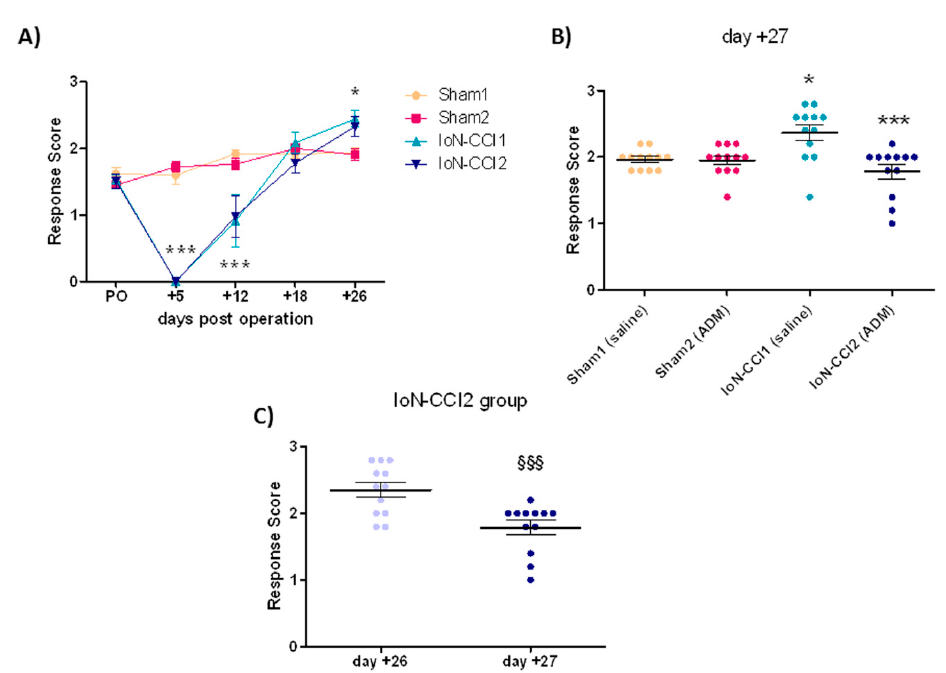
Figure 1. Mechanical stimulation testing (MST): ( A ) Mean response score to Von Frey hair stimulation of the ligated/sham infraorbital nerve (IoN) territory, on pre-operative day (PO) and on +5, +12, +18, and +26 days post operation. Data is expressed as mean ± SEM. Two-way ANOVA followed by Bonferroni post-hoc test, * p < 0.05 and *** p < 0.001 for chronic constriction injury of the infraorbital nerve (IoN-CCI) groups vs. Sham groups. Drug treatment effect on MST: ( B ) Mean response score to Von Frey hair stimulation on day +27, 1 h after ADM_12 (or saline) treatment. Data is expressed as